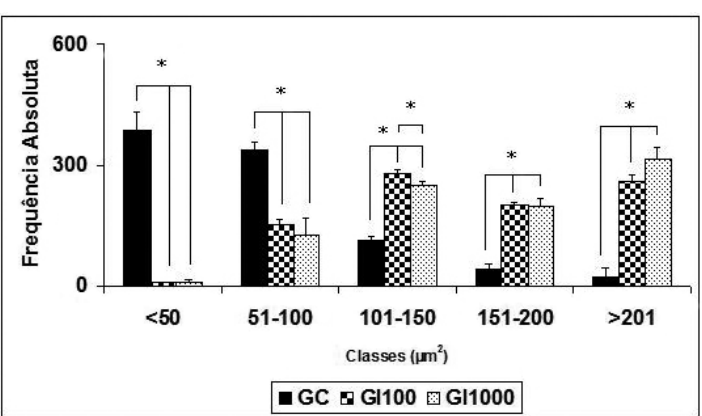
Fig. 3 – Histogram of the classes of myenteric neurons in the colon of Swiss male mice according to the area ( μ m 2 ) of the body cell in the animals inoculated with 100 (IG 100 ) and 1000 (IG 1000 ) trypomastigotes of T. cruzi Y strain at 75 dpi – days post inoculation and the non-infected controls (CG). (*) = (P < 0.0001).